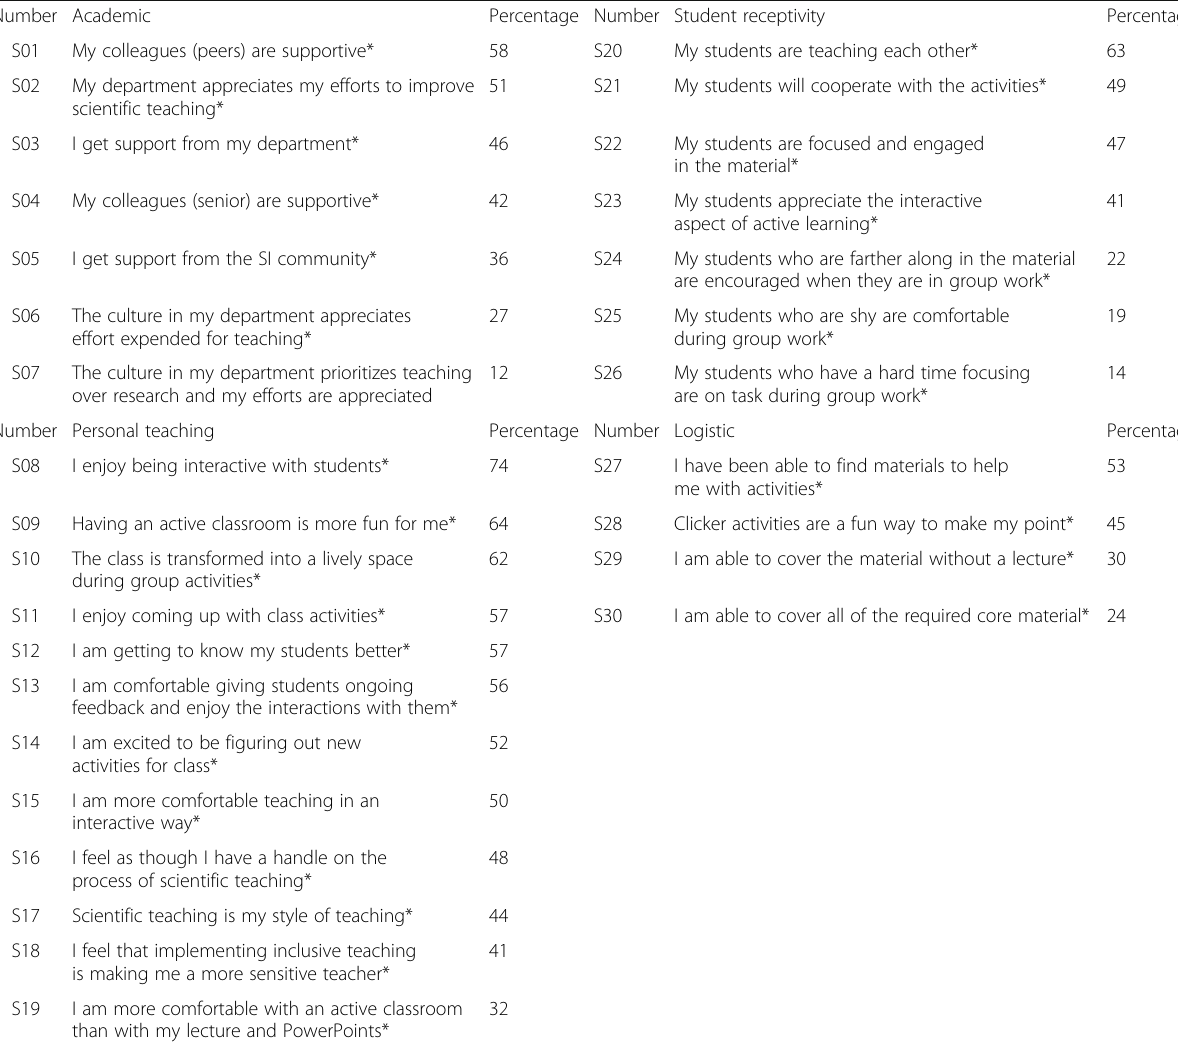
Table 2 Categories of supports with the percentage of instructors who perceive each item ( n = 584) Number Academic